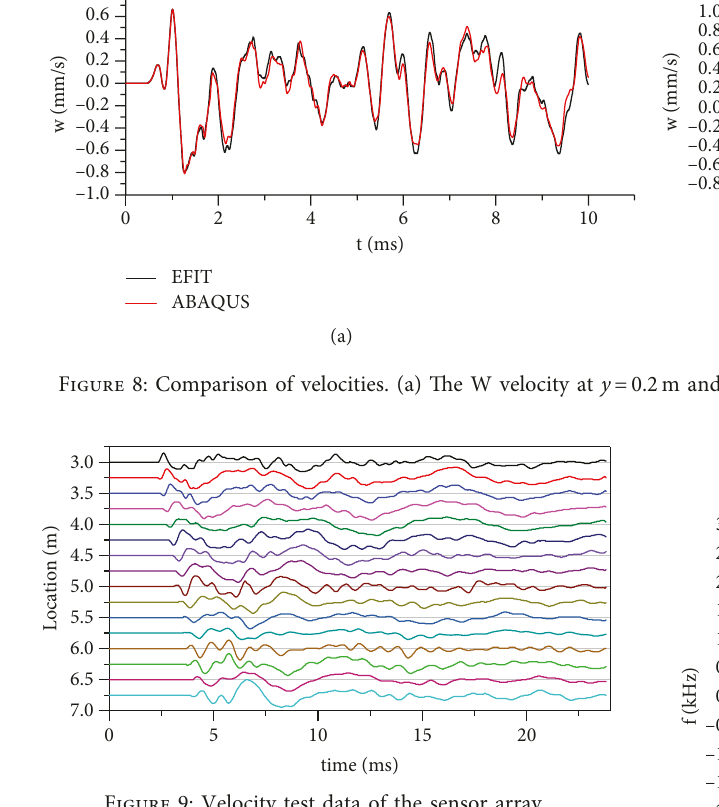
Figure 9: Velocity test data of the sensor array.